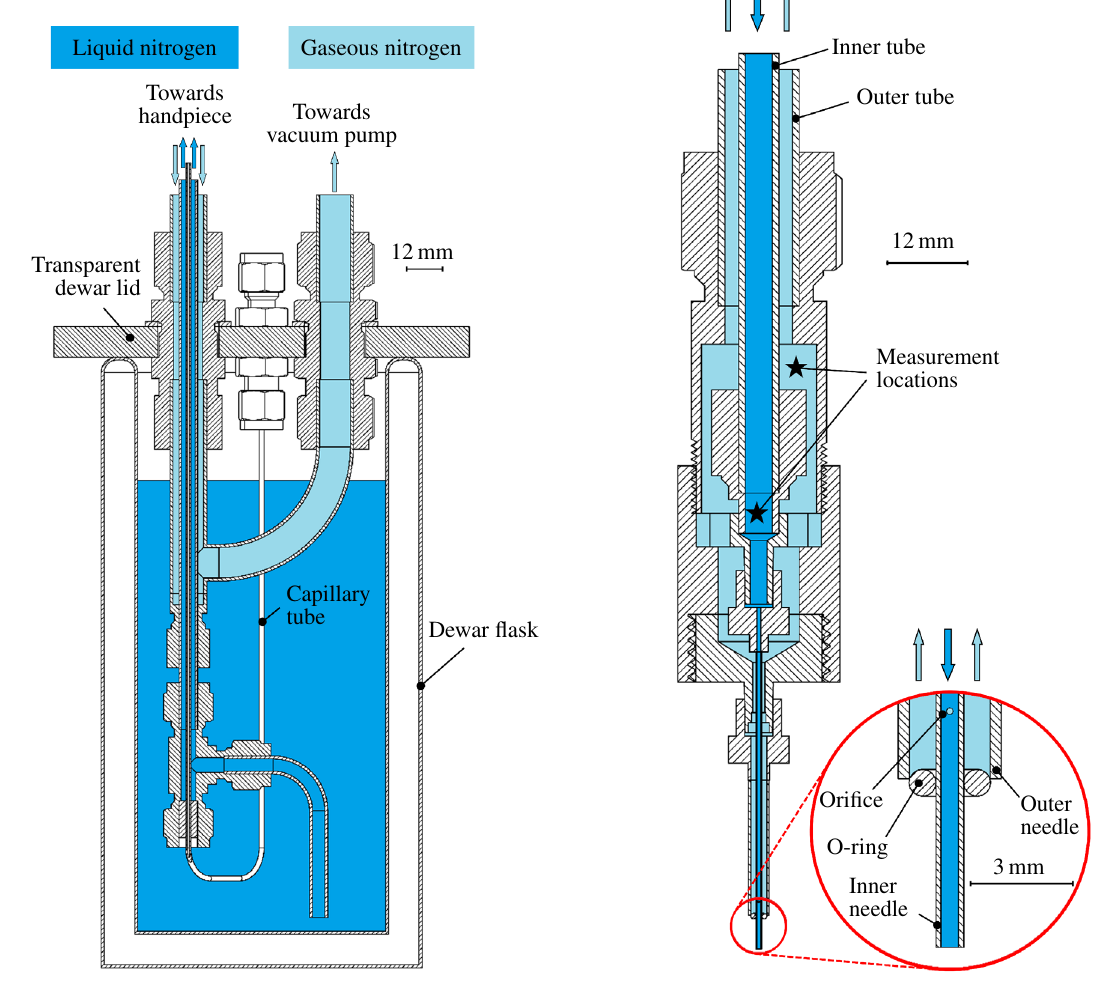
Figure 2. In-scale cross-sectional views of ( a ) the dewar flask with the tube connections for liquid and gaseous nitrogen inside and through its lid, and b) the device handpiece connecting the plain ends of the inner and outer flexible tube (top) with the inner and outer hypodermic needle (bottom), respectively. Arrows in the figures indicate the flow direction of liquid (dark blue) and mainly gaseous (light blue) nitrogen in the system. The lid connection used to pressurize the dewar and a filter element at the inner tube inlet are not shown in ( a ). Stars in ( b ) indicate the measurement locations for pressure and temperature in the liquid and gaseous domain inside the handpiece. The situation around the orifices in the inner needle tip is shown in a detailed view in ( b